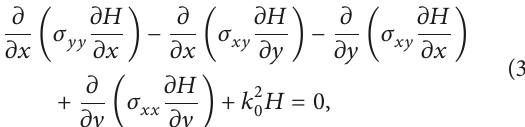
approximation it is not necessary to use continuous